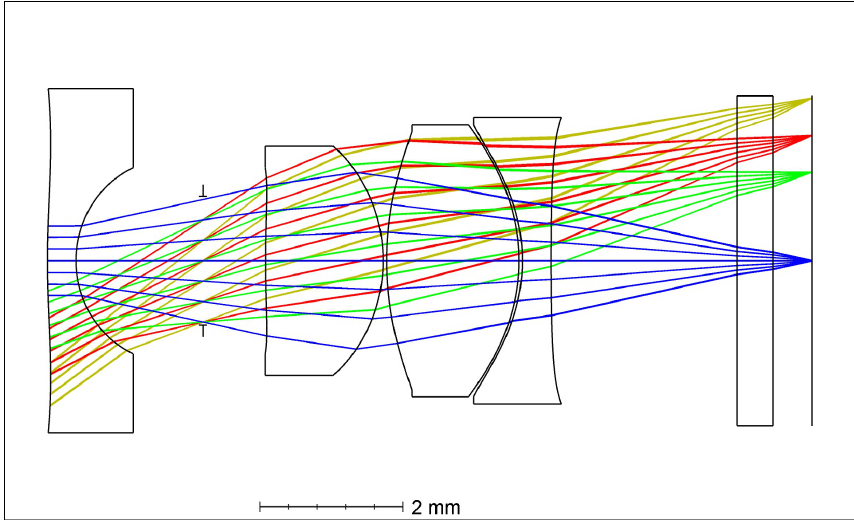
Figure 1. Optical layout of the optimized